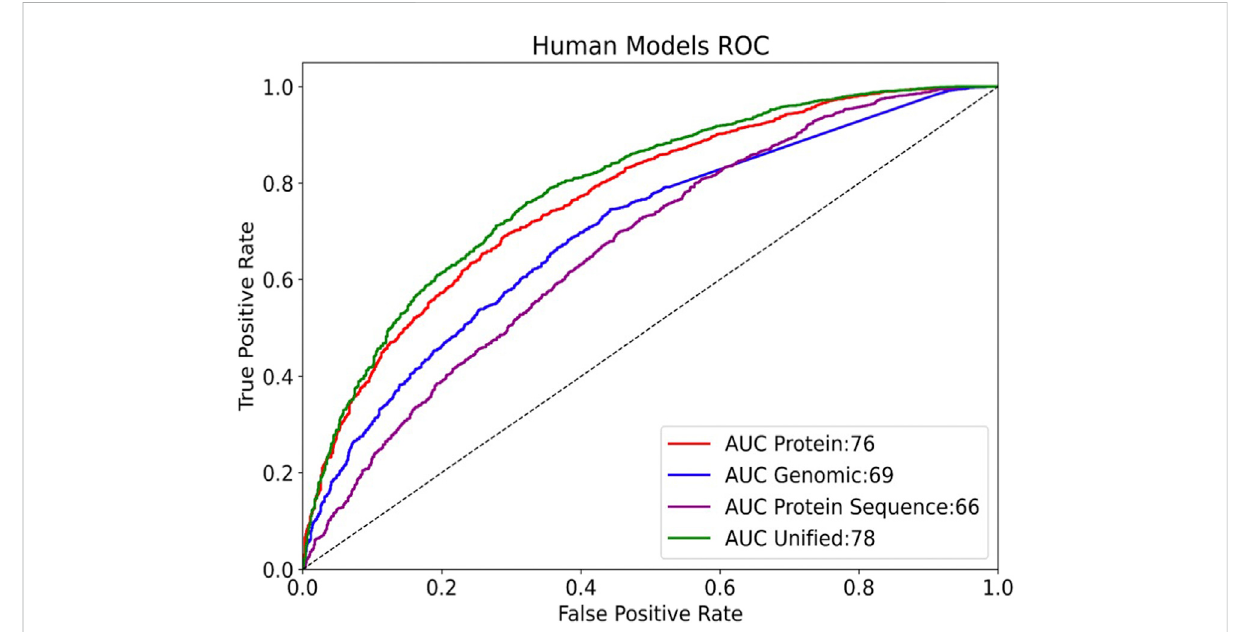
FIGURE 4 ComparingtherocAUC(AreaUndertheReceiverOperatingCharacteristicCurve)ofdifferentmodelsonhumandata.Resultsareshownforthe test set (3810 samples, 75.8% miRNA regulated). The “ Protein ” model includes functional annotations, keywords, primary sequences, and protein families. The “ Protein sequence ” model uses only protein sequence and derived features. A uni fi ed model includes all protein and genomic